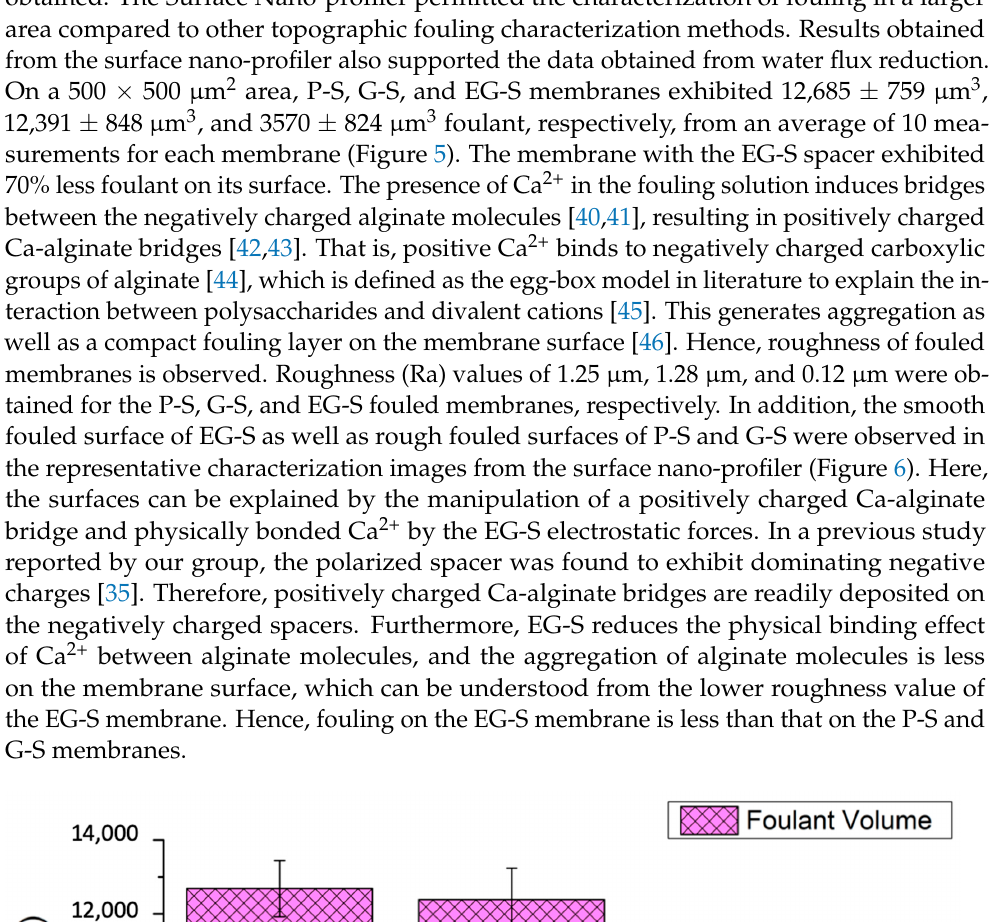
Figure 6. Surface profiles of the P-S, G-S, and EG-S fouled membranes (Roughness values also are provided on each figure). (Blue and red colors represent low fouling and high fouling thicknesses, respectively). By considering the spacer fouling issue, the effect of electric polarization was further investigated by measuring the total adsorbed foulant amount on the spacers G-S and EG- S. After dipping the G-S and EG-S spacers for 12 h, 20 mg and 31 mg foulants were ad- sorbed, respectively. After the cleaning process, both spacers exhibited the same amount of foulant on the surface (20 mg) (Figure 7). In here, electric polarization permitted the deposition of the foulant on EG-S with weaker adhesion, leading to a lower foulant dep- osition on the EG-S membrane.